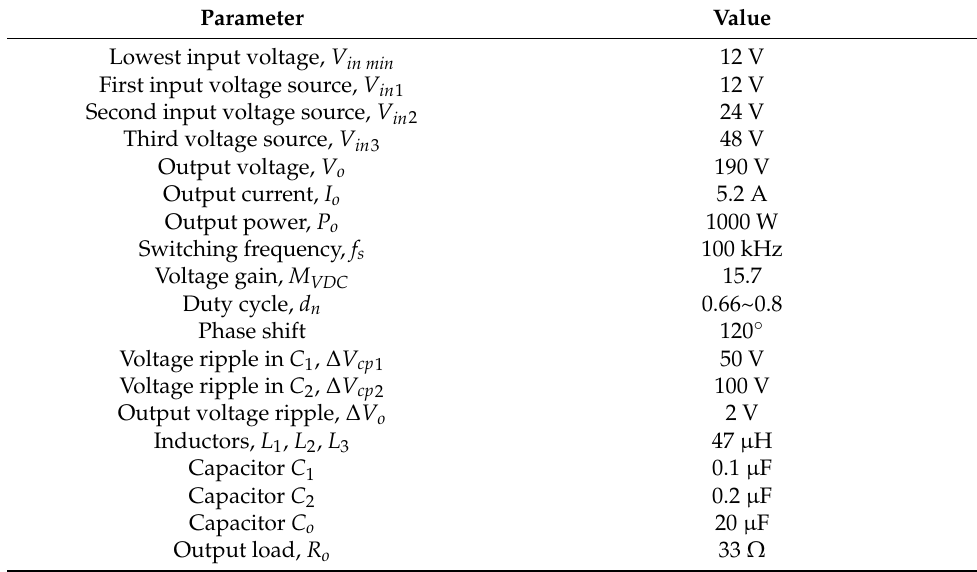
Table 2. Test parameters and